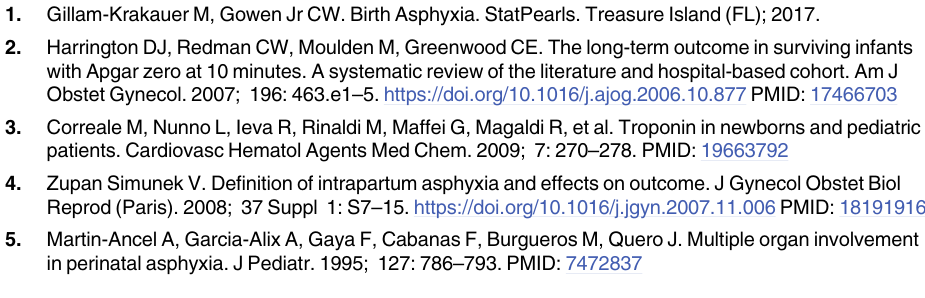
S1 Table. ARRIVE guideline checklist of animal research. S1 Fig. Results of TNF (S1A Fig) and IL-6 (S1B Fig) western blot 4 h after asphyxia and hemorrhage in newborn pigs with either NaCl (n = 6) or blood (RBC, n = 9) transfusion. Systemic levels of surfactant protein D in blood samples of pigs after asphyxia (S1C Fig), p = 0.05, n.s. = not significant, graphical representation as mean ±